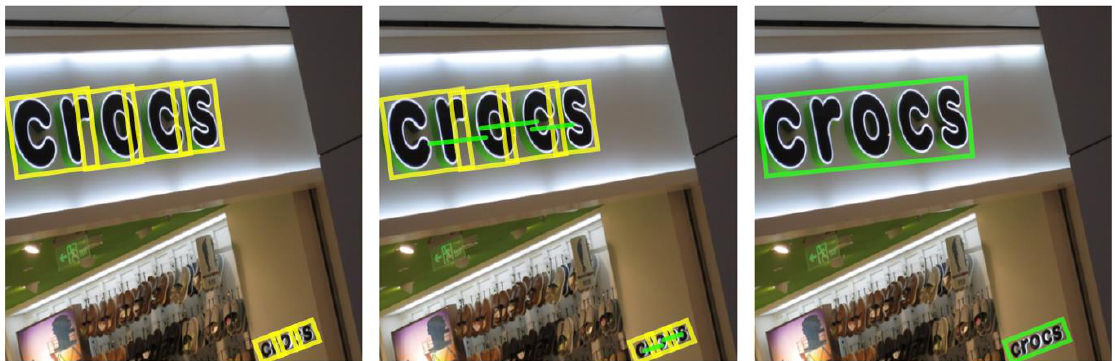
Figure 1. Illustration for Segment Linking (SegLink) processes [24].